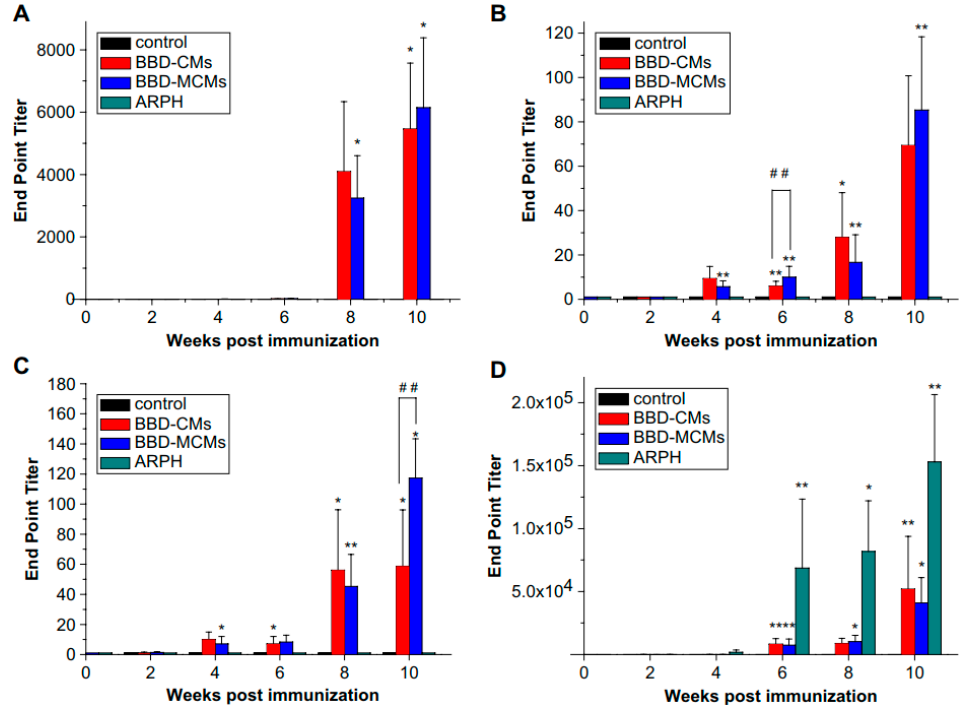
Figure 6. Anti-BBD IgA levels in ( A ) nasal wash; ( B ) saliva; ( C ) serum and ( D ) anti-BBD IgG levels in serum (data are means ± standard deviations, n = 3). Significant differences between untreated and immunized groups was expressed as * p < 0.001 and ** p < 0.05 and between BBD-CMs and BBD-MCMs groups as ## p < 0.05. (Reprinted with permission from Ref. [116]).